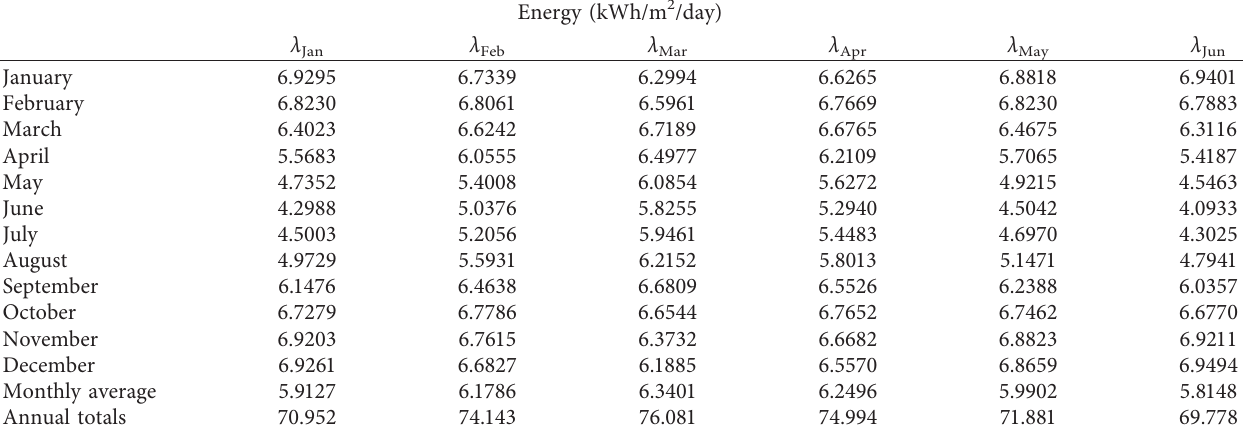
Table 3: Average daily solar energy outputs for January to June tilt angles.